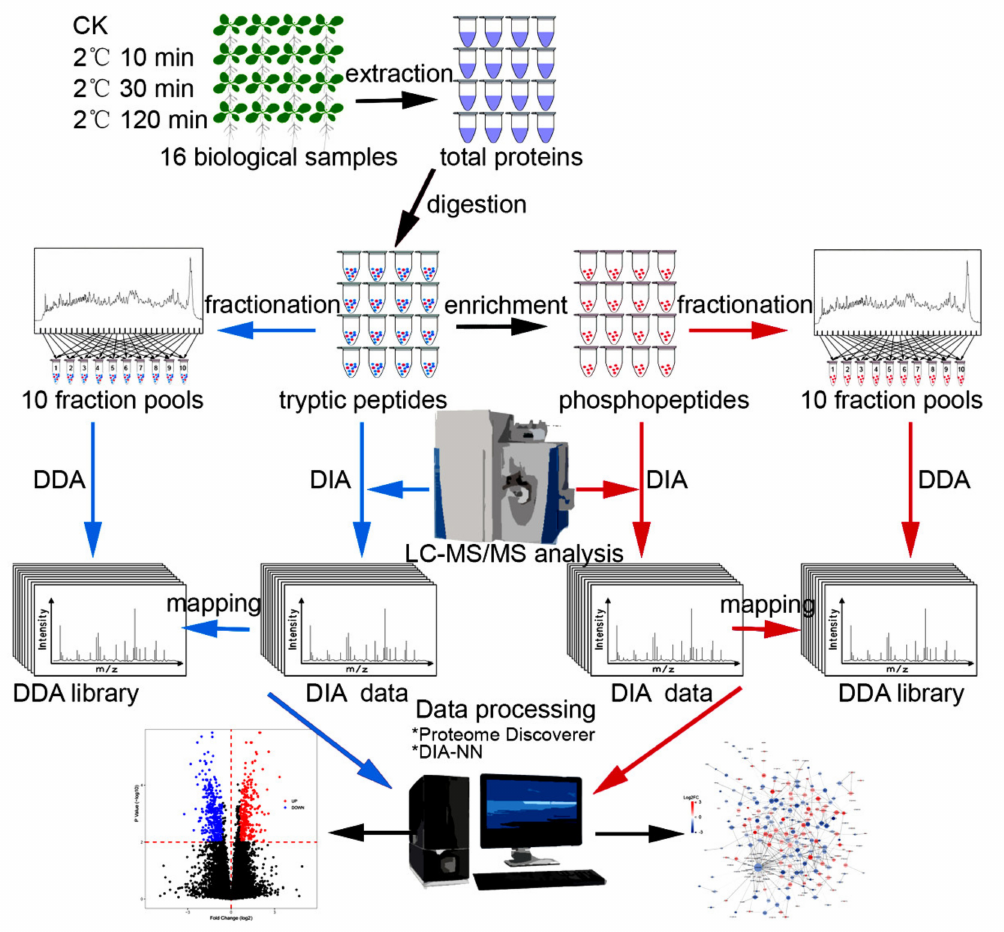
Figure 1. Schematic representation of the experimental workflow. Ga 3+ -based immobilized metal affinity chromatography (Ga-IMAC) was used to en- rich phosphopeptides in this study since it was shown to be reproducible and specific in purifying phosphoproteins in Arabidopsis seedlings [26] and efficient in enriching phos- phopeptides in Arabidopsis inflorescence tissues [27] and in rat pancreas [28]. A spectral library for phosphoproteome was constructed using Ga-IMAC enrichment followed by high-pH reversed-phase fractionation, LC-MS/MS analysis and identification by Proteome Discoverer (Figure 1 and Table S1, FDR < 1% for PSMs and peptide groups). We identified 47,362 phosphopeptides (or peptide isoforms), corresponding to 35,002 phosphopeptide groups, and most of the phosphopeptides were mono phosphorylated (85.9%), 12.1%